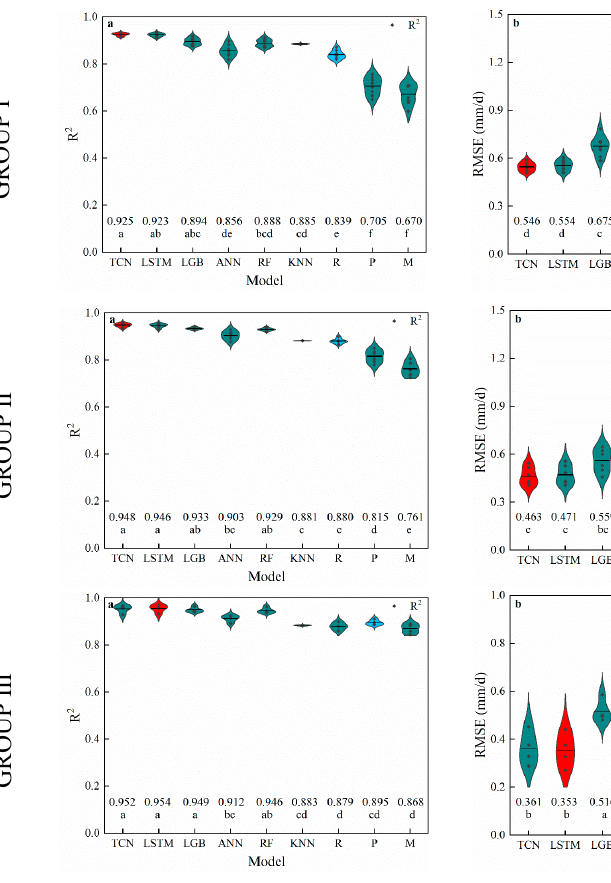
Figure 6. The performance of the radiation-based models during the second strategy: ( a ) determination coefficient (R 2 ), ( b ) root mean square error (RMSE), and ( c ) mean absolute error (MAE).